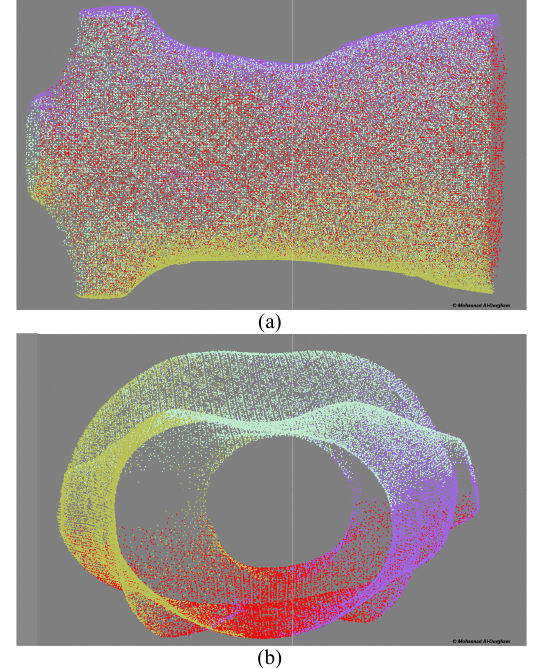
Figure 7: Side bef Table 2(a) a parameters res The transform discrepancy of